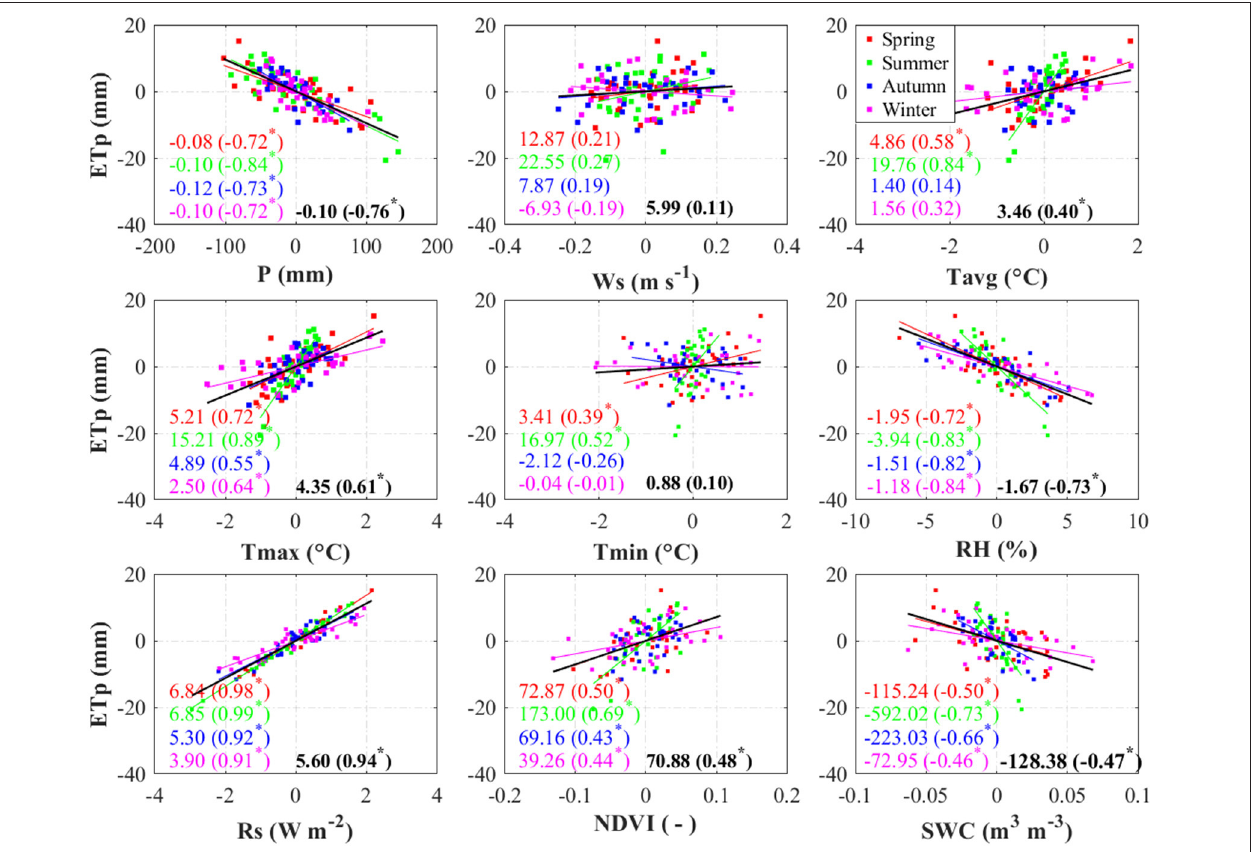
FIGURE 6 | Scatterplots of ET p against different variables in different seasons. Data were detrended. Black lines are regression results for data in all seasons which is equivalent to monthly data regression. Other colors correspond to the four seasons as shown in the legend in the third plot of the upper panel. Numbers outside and inside the brackets are regression slopes and correlation coefficients, respectively. Asterisks infer statistically significant linear regressions.